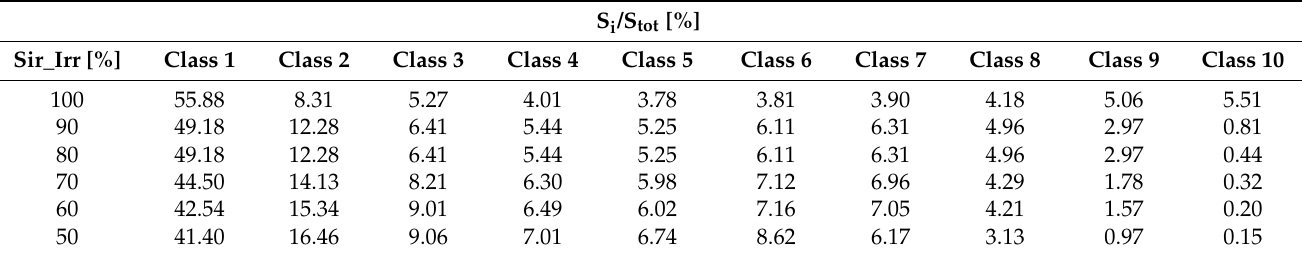
Table 7. Values of the ratio between the surface areas S i and the total area of the province S tot for the deficit irrigation from 100% to 50% of the actual value and the ten classes, for the RF model. S i /S tot